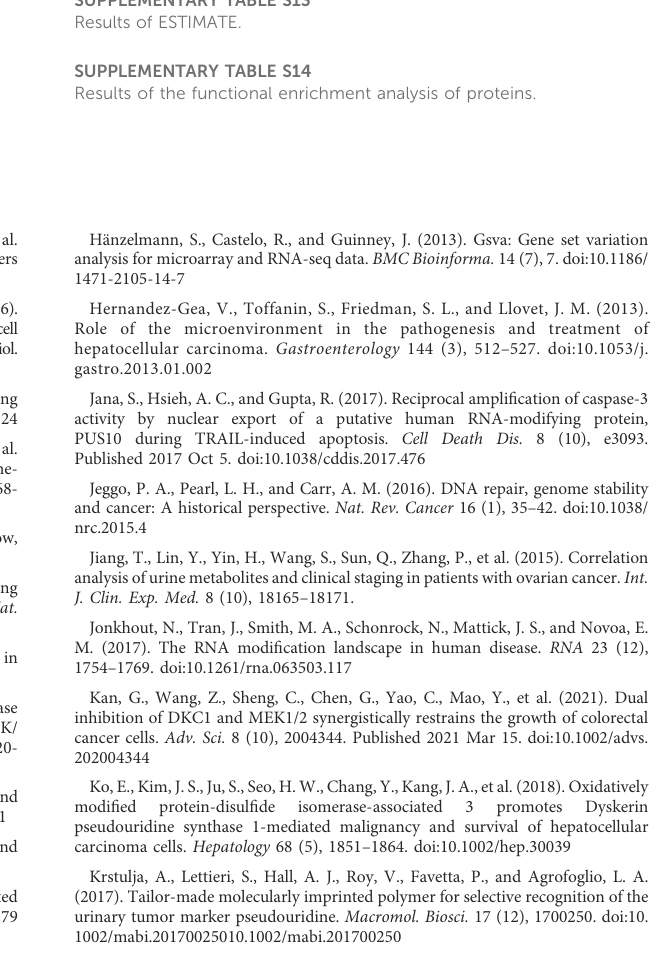
SUPPLEMENTARY TABLE S12 Results of ssGSEA. SUPPLEMENTARY TABLE S13 Results of ESTIMATE. SUPPLEMENTARY TABLE S14 Results of the functional enrichment analysis of